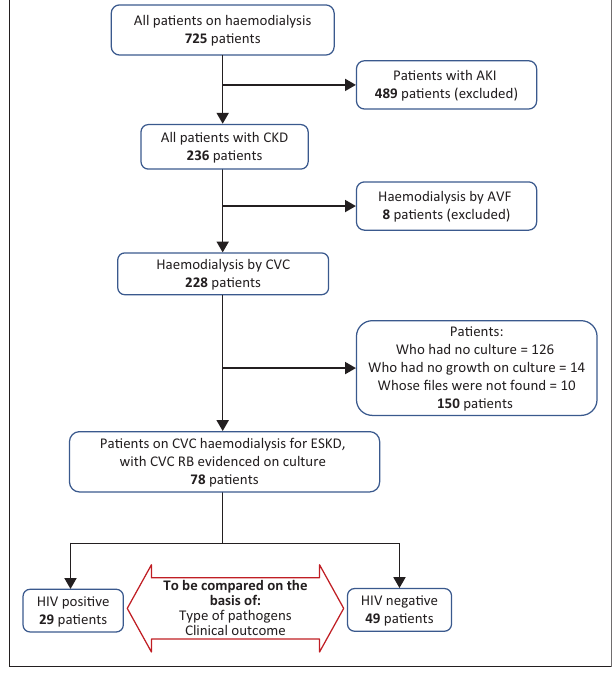
FIGURE 1: Patient